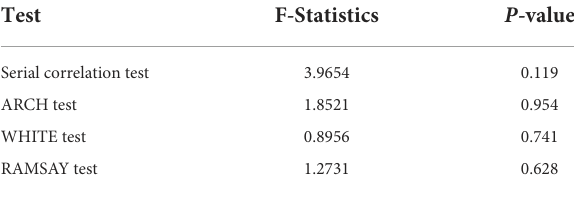
TABLE 8 Model stability